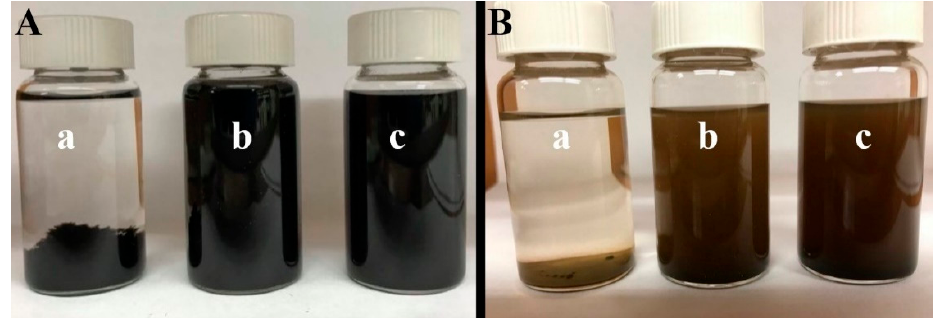
Figure 2. Sedimentation test for ( A ) carbon nanotubes (CNT) and ( B ) MnO 2 prepared ( a ) without dispersants and in the presence of ( b ) chlorogenic acid and ( c ) 3,4,5-trihydroxybenzamide.